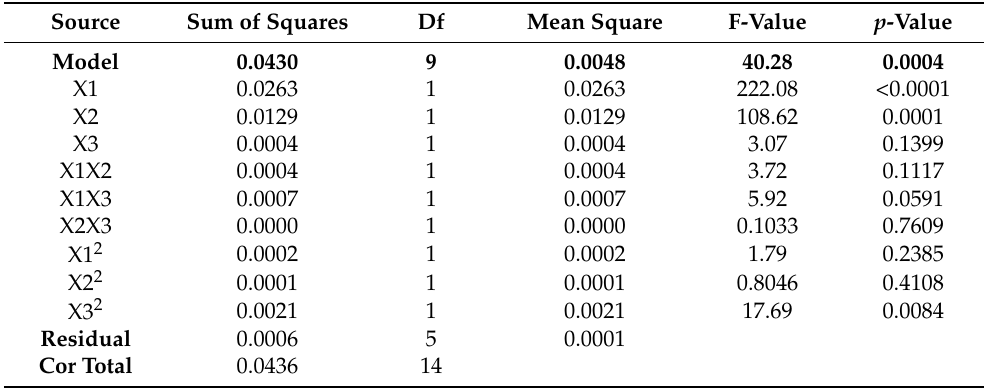
Table 9. ANOVA for Quadratic model of PDI